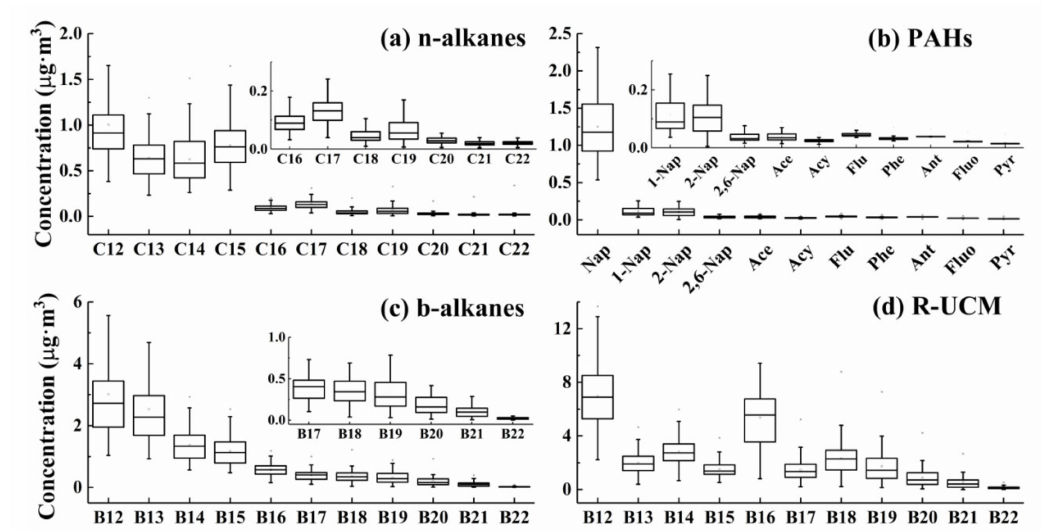
Figure 3. Component concentrations of ( a ) n -alkanes, ( b ) PAHs, ( c ) b -alkanes, and ( d ) R-UCM. (The top to the bottom of the box chart represents the maximum, quartile, median, lower quartile, and minimum of the concentration of each species. B -alkanes and R-UCM are the parts of each bin with the same X-coordinate axis).